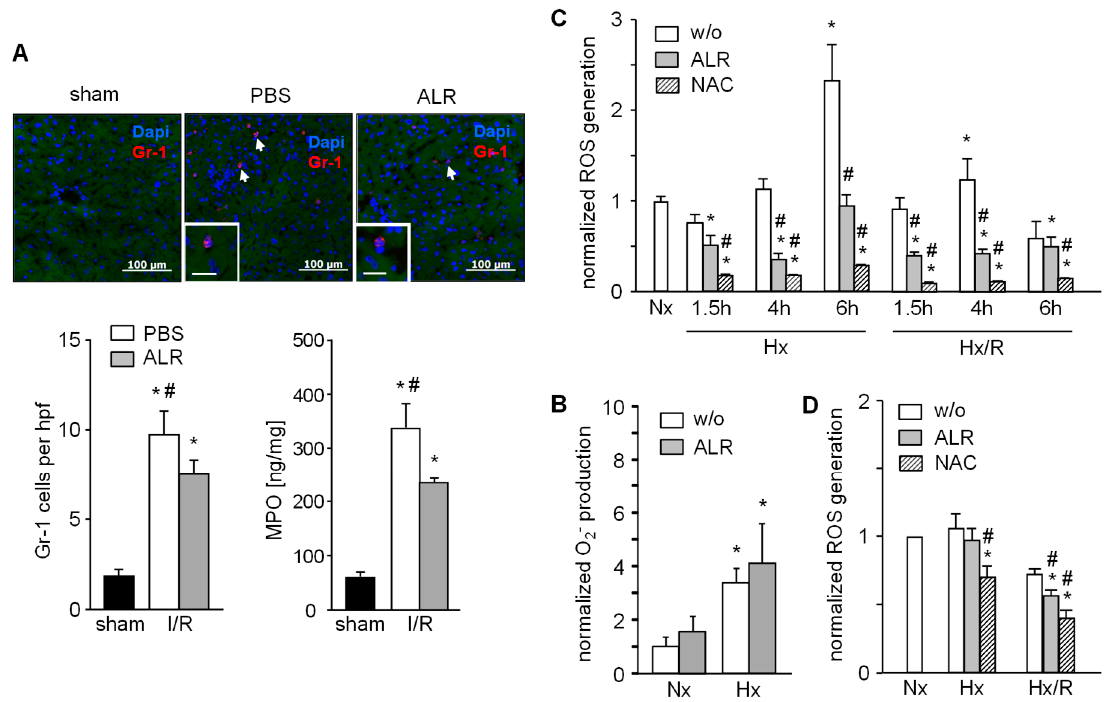
Figure 3. ALR decreases number of infiltrating neutrophils (GR-1) in an IRI mouse model and reduces generation of ROS in macrophages (RAW264.7) and primary hepatocytes upon hypoxia/reoxygenation. ( A ) Liver tissues from IR mice were immuno-stained for GR-1 and the number of infiltrated GR-1 positive cells were analyzed in each group. In addition, neutrophil resident myeloperoxidase (MPO) in these samples was analyzed ( n = 6). * p < 0.05 or # p < 0.05 differs from sham or IR/ALR group, respectively. ( B ) Gr-1 positive cells were isolated from mouse spleen and analyzed for O 2 − release into culture medium after 1 h of normoxia (Nx) or hypoxia (Hx) without (w/o) or with ALR (100 ng/mL) treatment ( n = 3). ( C ) RAW 264.7 cells (mouse macrophage cell line) were subjected to hypoxia or hypoxia with 2 h of reoxygenation (Hx/R) for the indicated times, in the absence or presence of rALR (100 ng/mL), following analysis of oxygen radical generation ( n = 3). Treatment with radical scavenger 10 mM n -acetylcystein (NAC) was used as positive control. ( D ) Primary mouse hepatocytes were subjected for 4 h to hypoxia or hypoxia with 2 h of reoxygenation in the absence or presence of rALR (100ng/mL) following analysis of oxygen radical generation by performing a H 2 DCFDA assay. Results ( n = 4) are normalized to Nx with * p < 0.05 or # p < 0.05 differs from Nx or corresponding HX, Hx/R w/o ALR treatment, respectively.